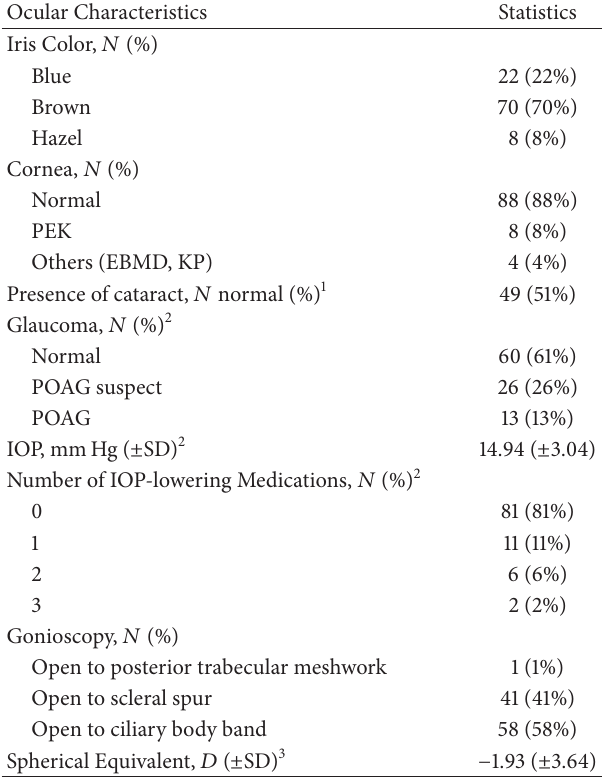
Table 1: Baseline ocular